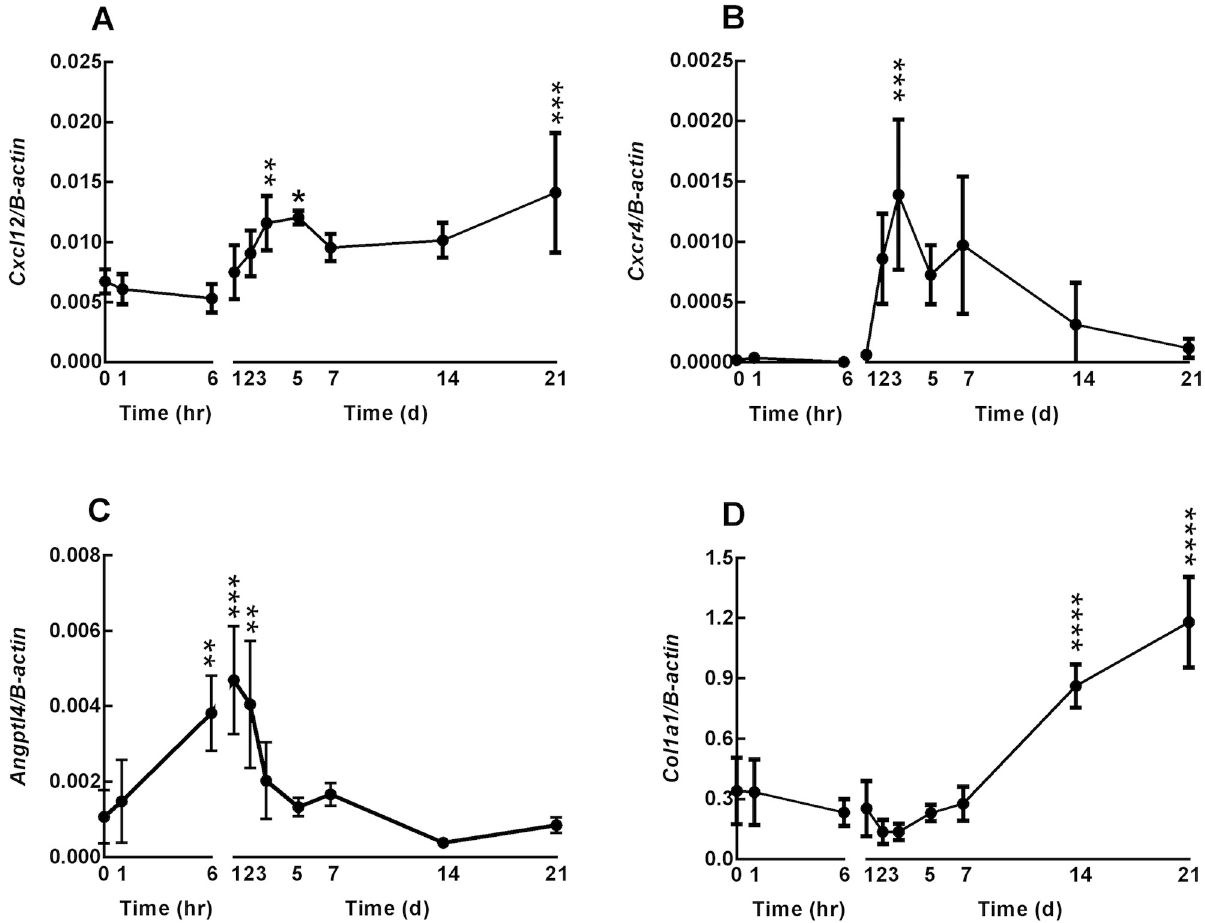
Fig 4. Gene expression during wound healing. A. Cxcl12 , B. Cxcr4 , C. Angptl4 and D. Col1a1 . Expression levels were measured at 0, 1 and 6 hr and from 1–21 days following ear punch. Results are expressed as mean Δ CT ± SEM, normalized to beta-actin transcript level, n = 3–6. Data significant by one-way ANOVA to time zero as indicated ( � p < 0.05, �� p < 0.01, ��� p < 0.001, ���� p < 0.0001).